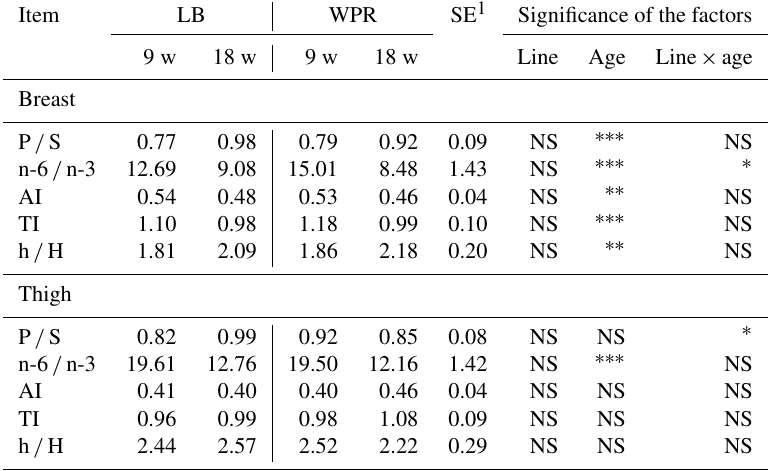
Table 5. Fatty acid indices in breast and thighs in La Belle (LB) and White Plymouth Rock (WPR) chickens according to the line and age. Item LB WPR SE 1 Significance of the